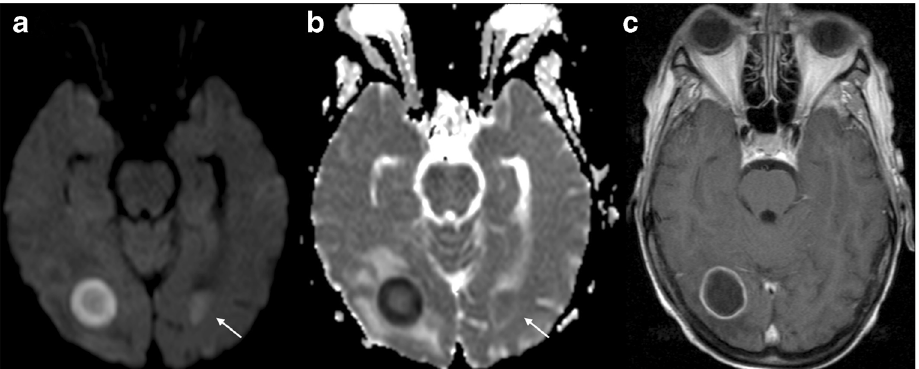
Fig. 10 Abscess. Right occipital mass showing marked diffusion restrictionwithin thecore onDWI and ADC maps ( a and b , respectively) and a peripheral enhancing pattern on T1 post gadolinium ( c ). DWI helps to differentiate ring-enhancing le- sions because restricted diffusion